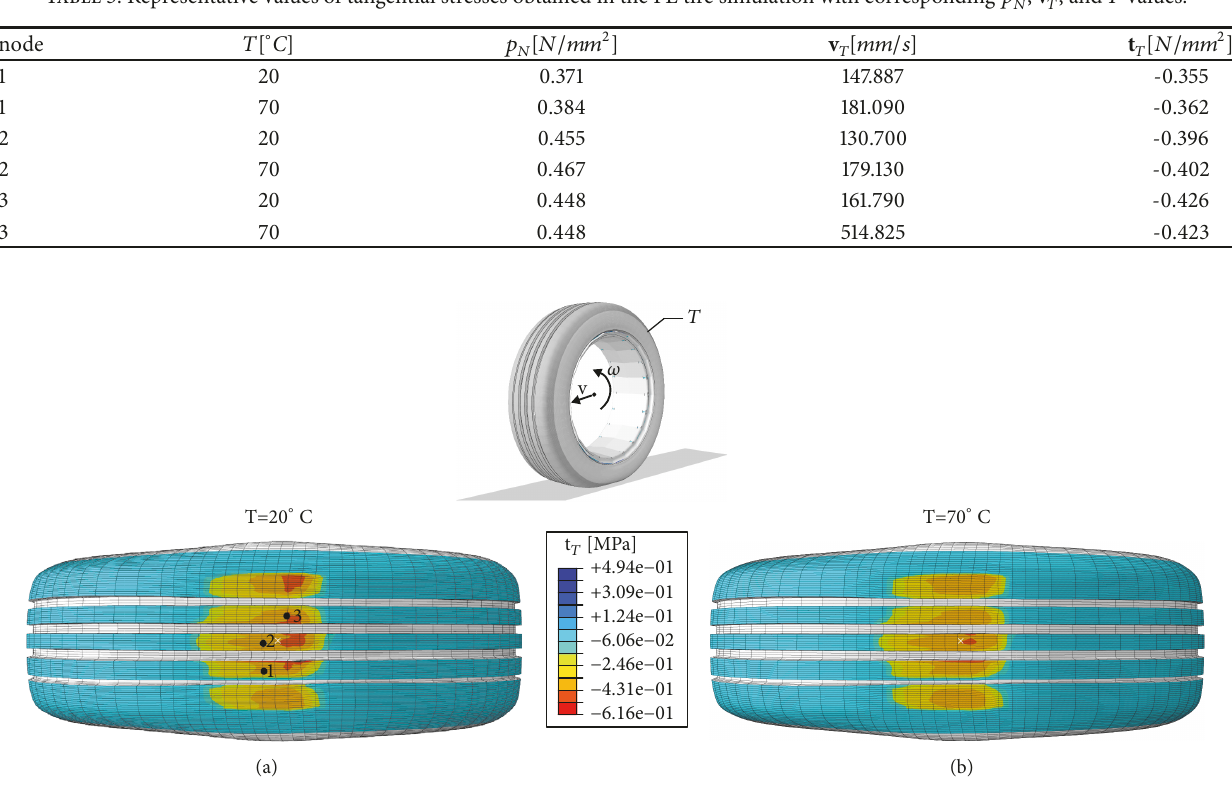
Figure 14: Tangential stress distribution in the contact interface of a rolling